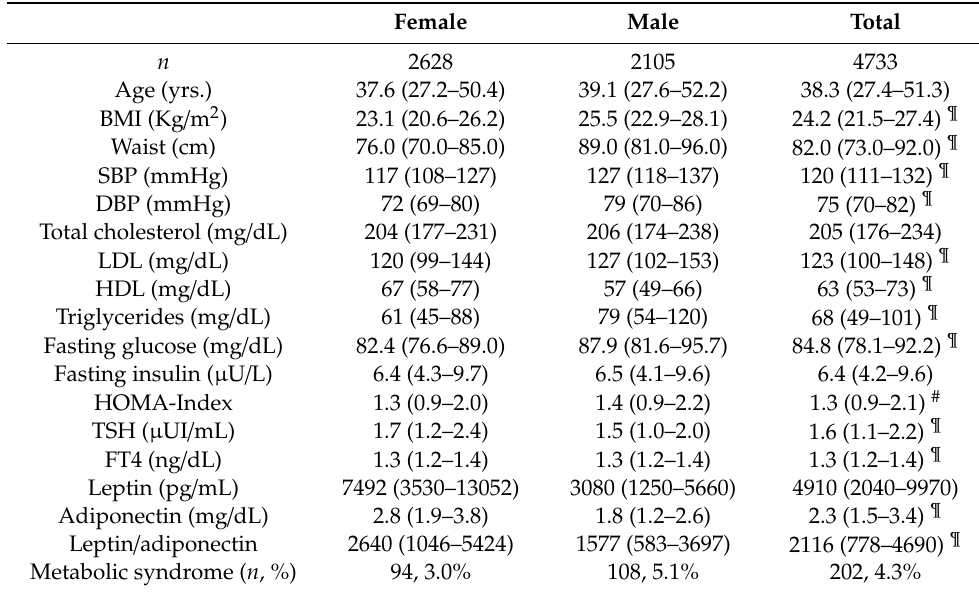
Table 1. Descriptive characteristics of cardiovascular risk factors of the sample.